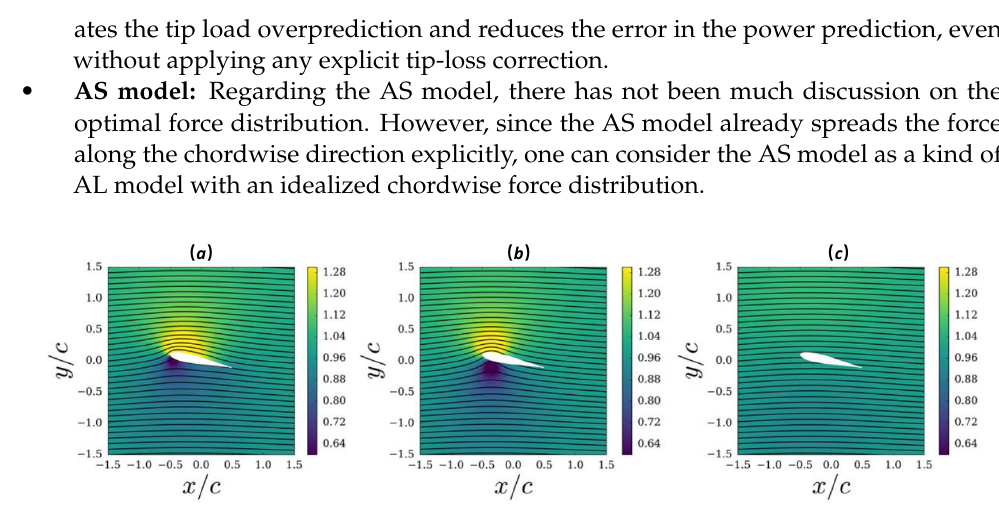
Figure 6. Contours of the velocity magnitude and the streamlines. ( a ) Potential flow solution for a symmetric Joukowski airfoil. ( b ) With optimal ε = 0.14 c . ( c ) With non-optimal ε = c . ( b , c ) Based on linearized Euler equation. Reprinted with permission from Ref. [65]. 2017, John Wiley and